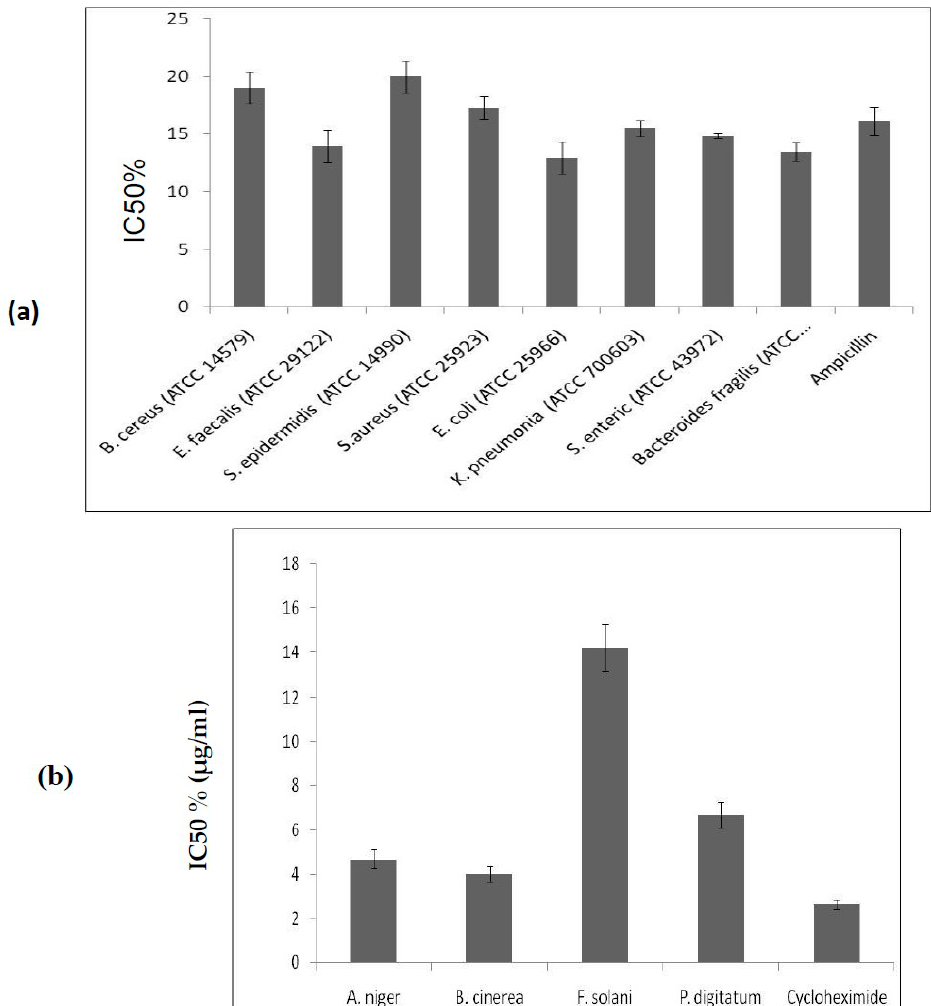
Figure 7. ( a ): Antibacterial properties of the purified protease inhibitor PDInhibitor. The antibacterial properties of PDInhibitor were evaluated against several gram-positive and gram-negative